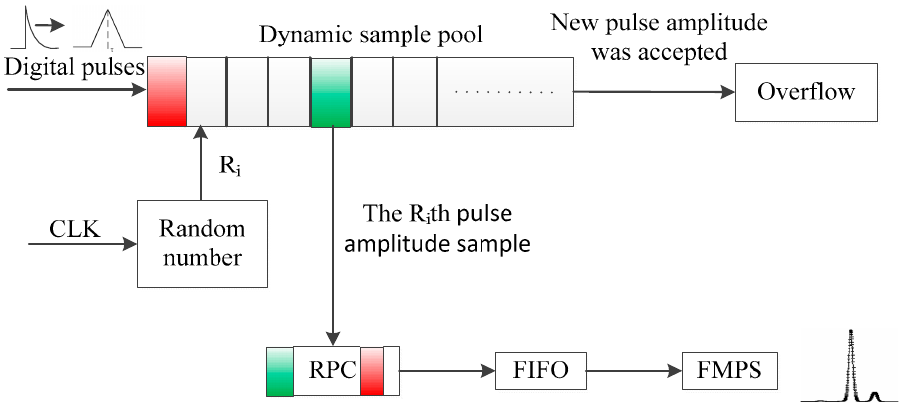
Figure 1. Counting rate multiplication principle.